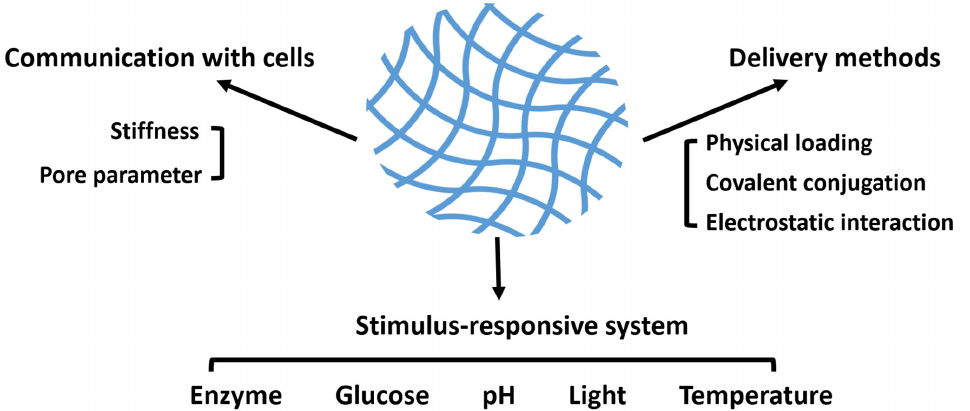
Figure 1. General scheme of the essential parameters of hydrogels applied in craniomaxillofacial bone regeneration. Physical and chemical properties, such as stiffness and mesh size, endow hydrogels with the ability to communicate with cells and to transport a variety of cargoes. Furthermore, in order to obtain a better effect of bone repairment, several potential stimulus-responsive systems are